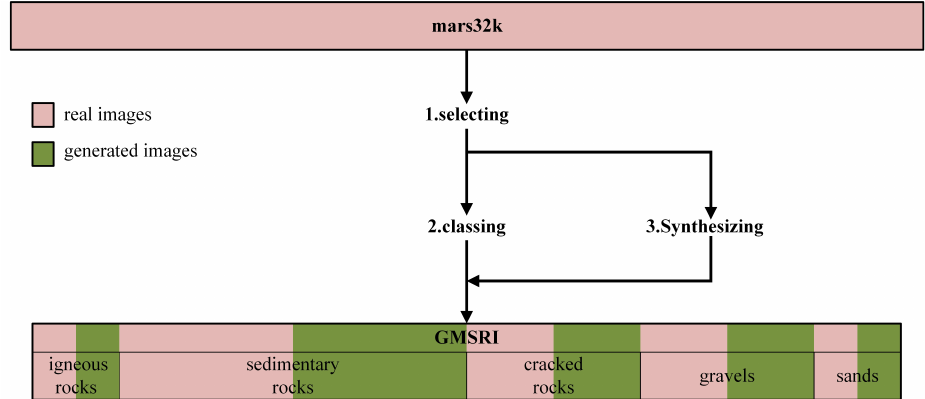
Figure 4. Overview of our proposed method. Mars32k is the database of raw Mastcam images. The processing steps are as follows: 1. Small-field rock images are selected from mars32k. 2. Small- field rock images are classed into five subsets. 3. Using a style-based generator, which is trained by selected images, to synthesis different types of Martian rock images. GMSRI is made up of the selected real images and the generated images.